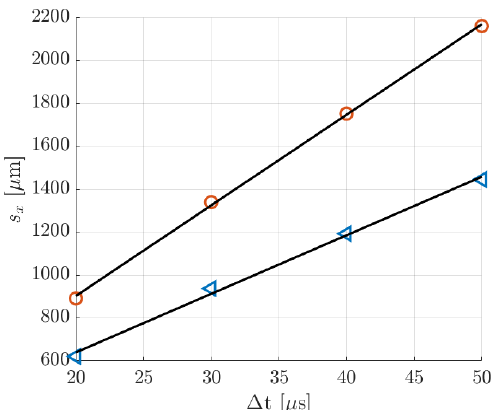
Figure 20. Mean molecular displacement s x in helium flow at delays ∆ t = 20, 30, 40, and 50 µ s: (O) data at 1.6 kPa; (